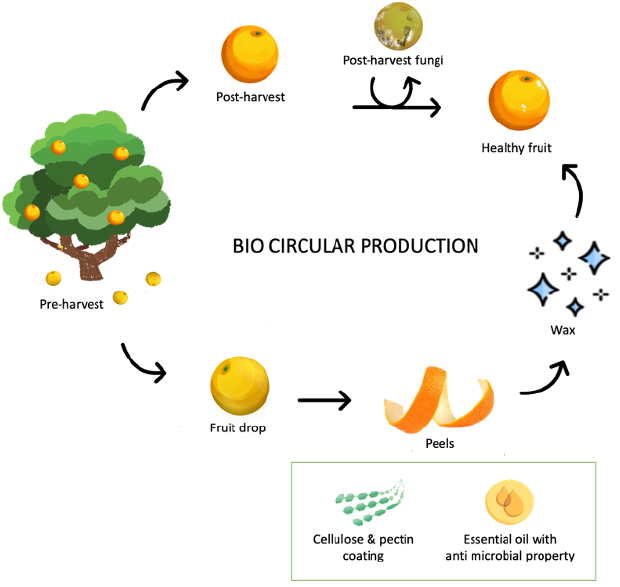
Figure 7. A proposed bio-circular approach for citrus fruit production.